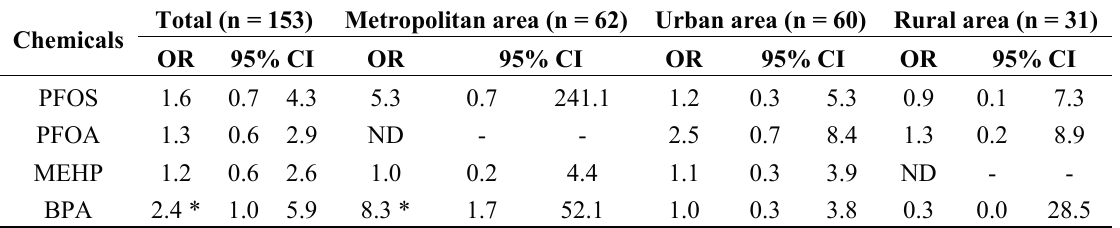
Table 4. Infertility risk factors associated with endocrine disrupters (ED) exposure (serum concentration >LOD) in enrolled women grouped by area of